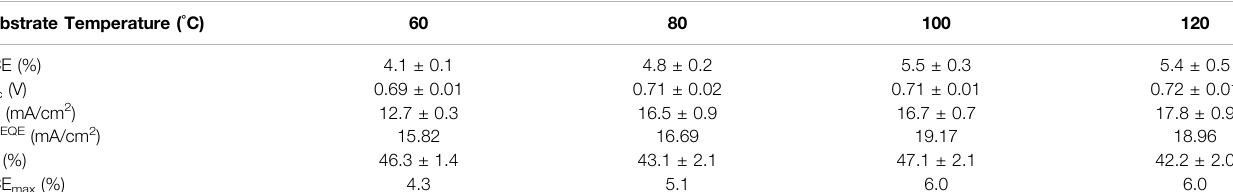
TABLE 1 | PV parameters extracted from the J-V curves of PM6:Y6 devices fabricated at different temperatures. Average values are calculated from eight devices, and the standard deviation is shown as the error. Substrate Temperature ( ° C)